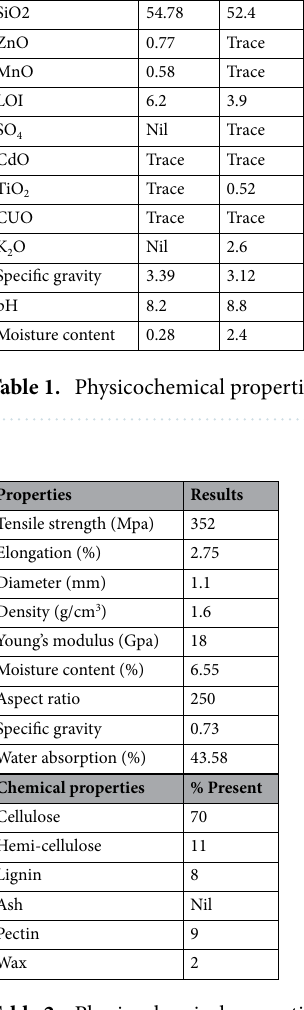
Table 2. Physicochemical properties of sisal fiber (source 20